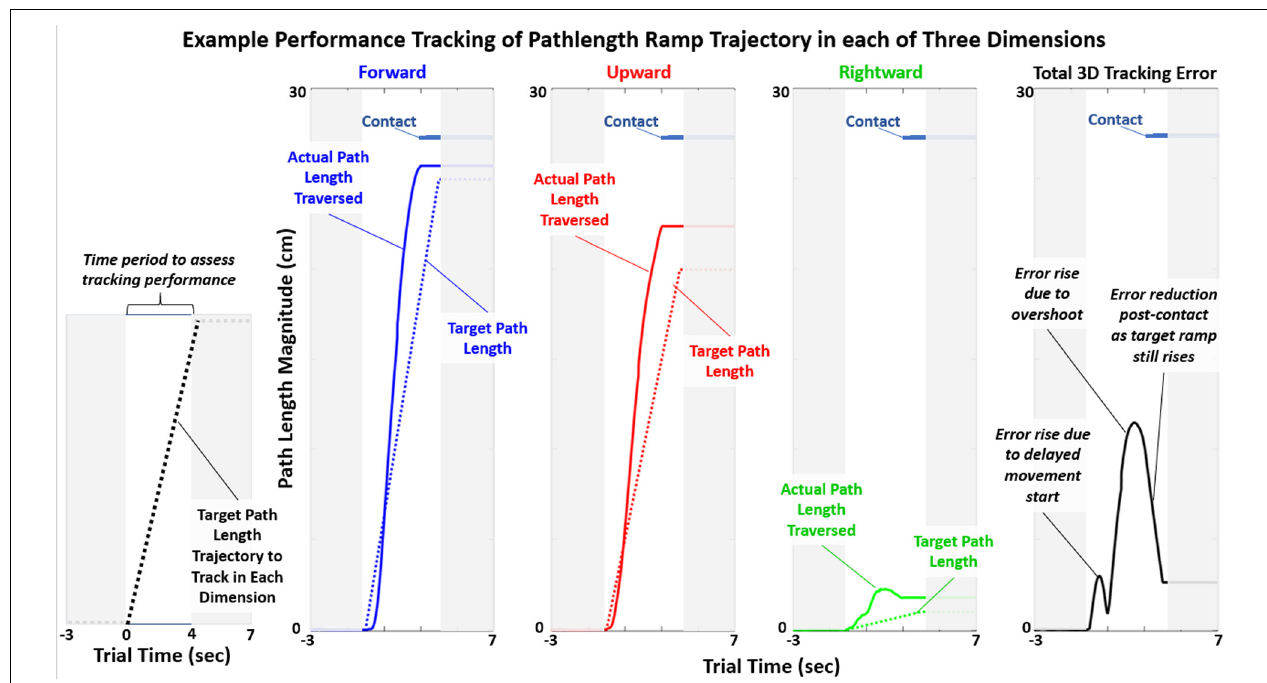
FIGURE 5 | Example tracking of target path length shown for one subject during “Baseline” test case. The target path length changes linearly in time (“ramp”) in each of the three dimensions (3D). The primary performance metric in this study was the average total 3D tracking error during the time period of the target ramp (between t = 0 and 4